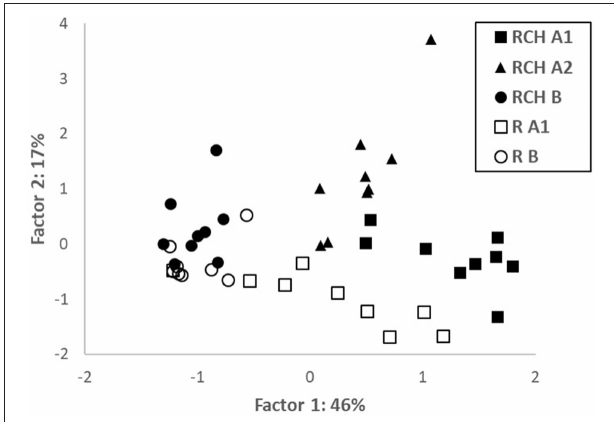
Frontiers in Environmental Science |